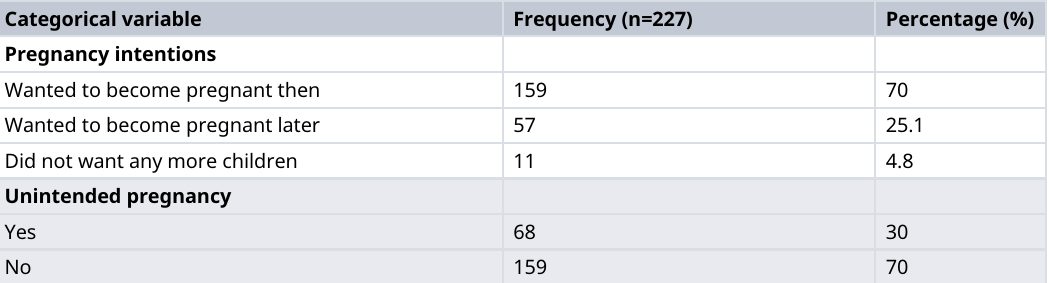
Table 2. Practices on family planning practices among study